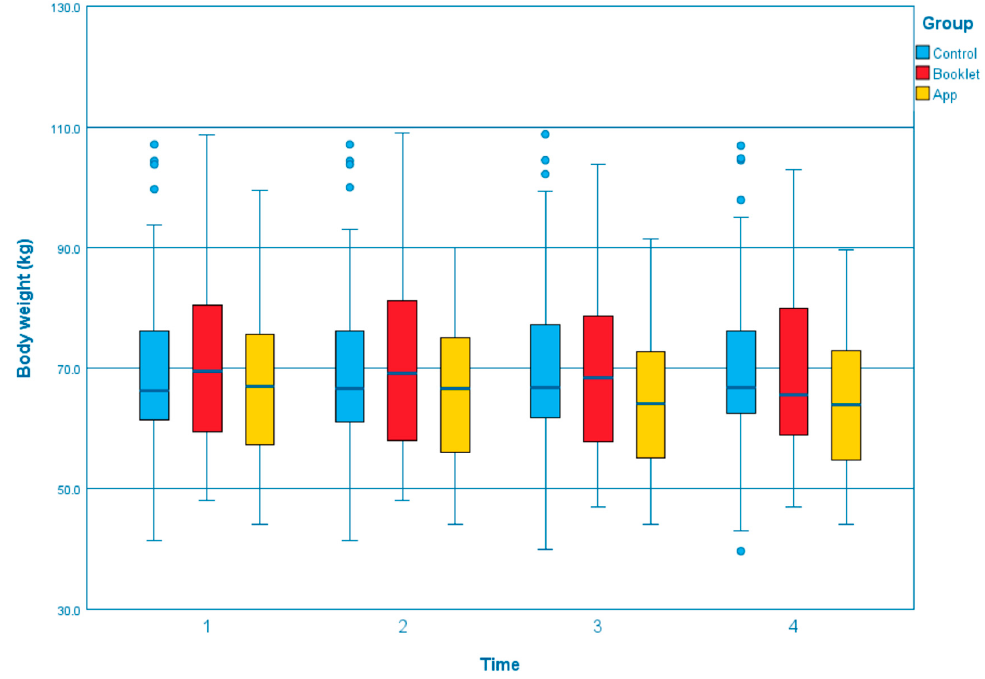
Figure 1. Boxplot of the change of body weight at different time point among the groups.